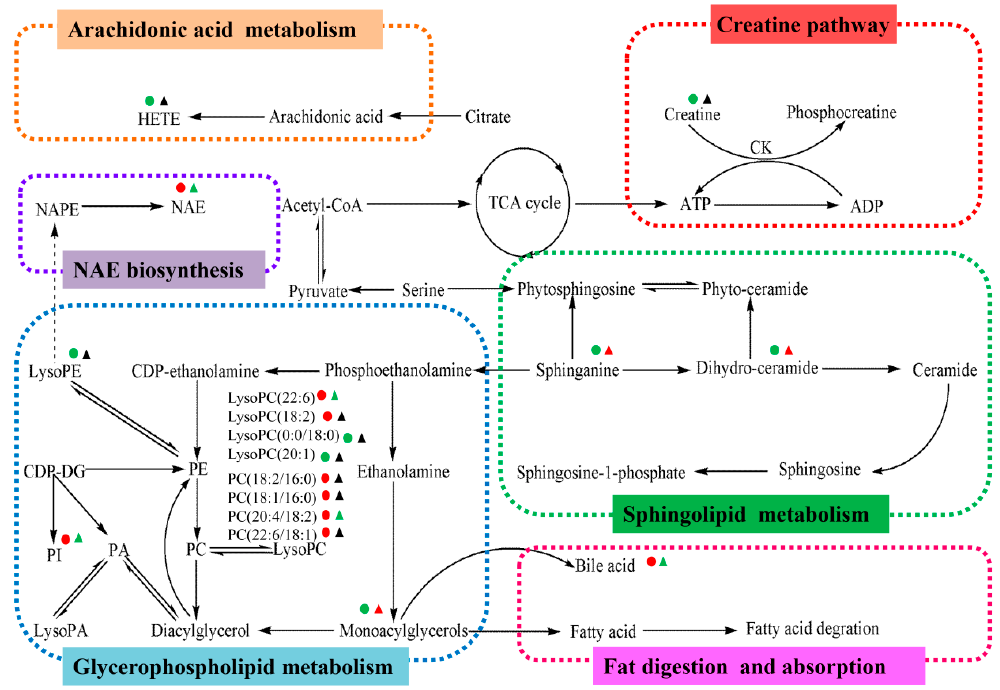
Figure 8. Metabolic pathway of CCl 4 -induced liver fibrosis and the anti-fibrotic effects of JGG . Content change tendencies are expressed according to the color: red, significant increases ( p < 0.05); green, significant decreases: ( p < 0.05); black, no significant changes ( p > 0.05). The model group compared to the control group; the JGG group compared to the model group.